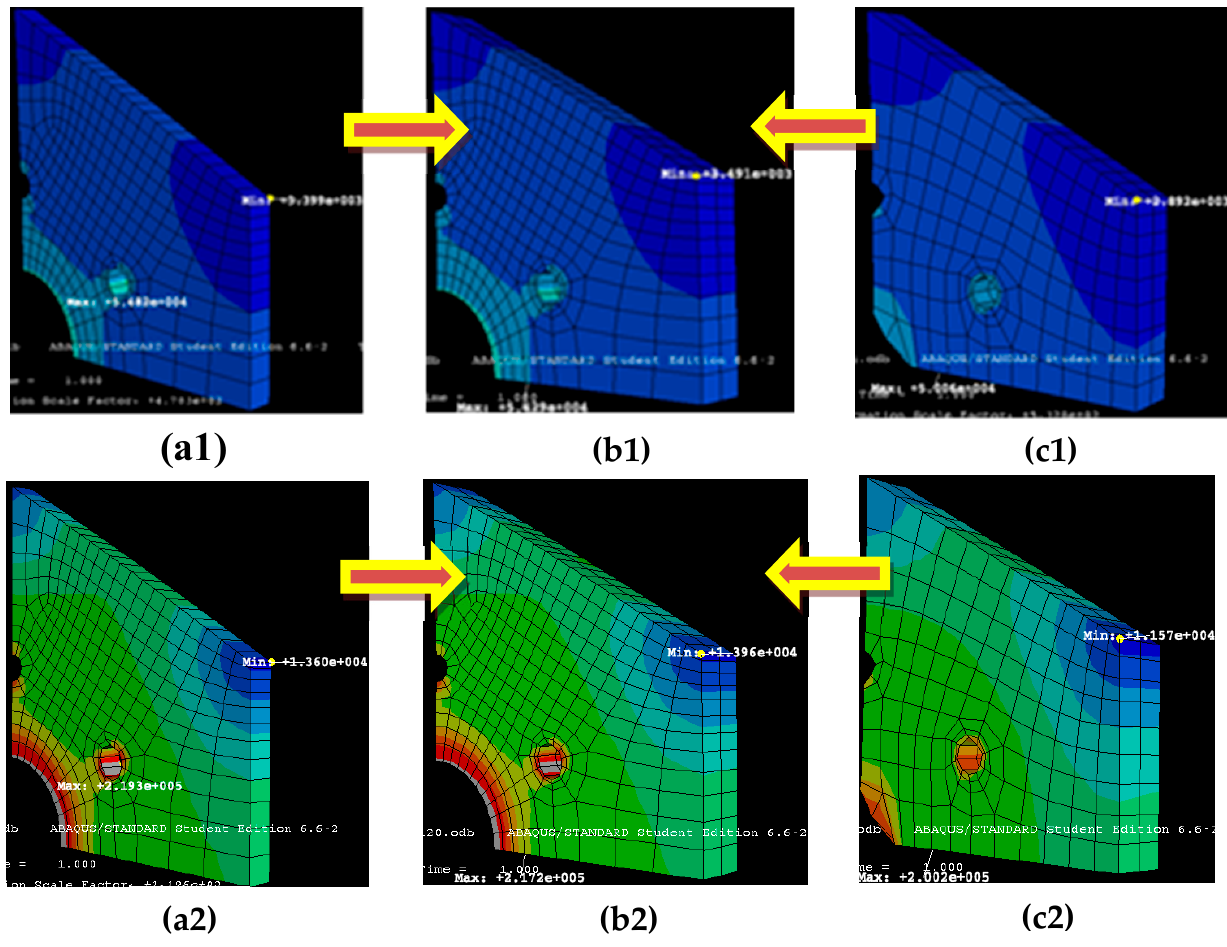
Figure 14. FEA of a hexagonal PM (with R = 25 mm) for two levels of ω , ( 1 ) 60 krpm and ( 2 ) 120 krpm, for a change in the width b from ( a ) 5 mm to ( b ) 10 mm, as well as for a change in the radius r of the central shafts, from ( c ) 2.5 mm to ( b ) 5 mm. For ( a ) r = 5 mm, while for ( c ), b = 10 mm.